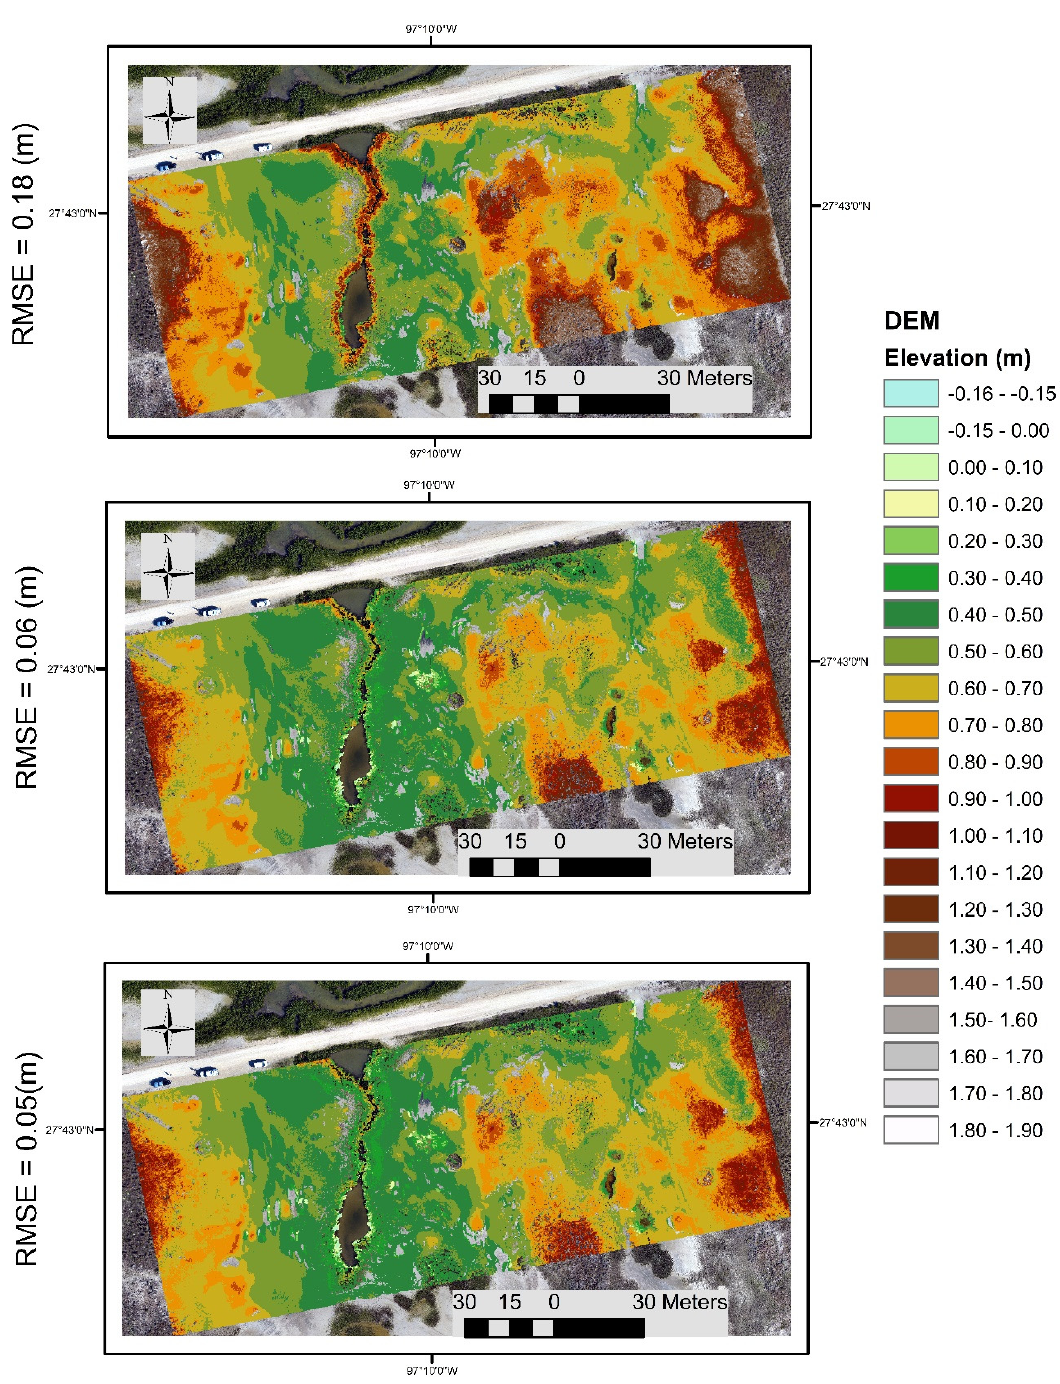
Figure 7. Comparison of the uncorrected ( top ) and ENN corrected digital elevation models (DEMs) for 6 ( middle ) and 12 inputs ( bottom ) for the 47th selected run from Section 4.1.